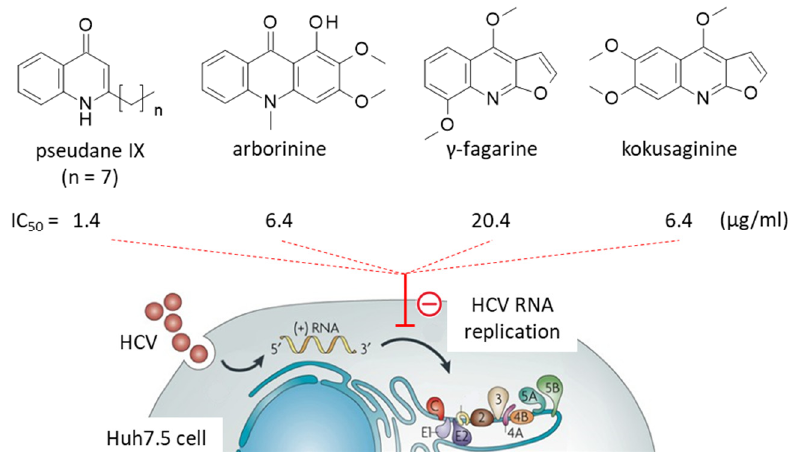
Figure 3. Inhibition of HCV RNA replication by the alkaloids pseudane IX, γ -fagarine, arborinine, and kokusaginine isolated from Ruta angustifolia Pers. The most potent alkaloid is pseudane IX which inhibited replication more potently than the reference product ribavirin (IC 50 = 1.4 and 2.8 µ g/mL, respectively) [21].